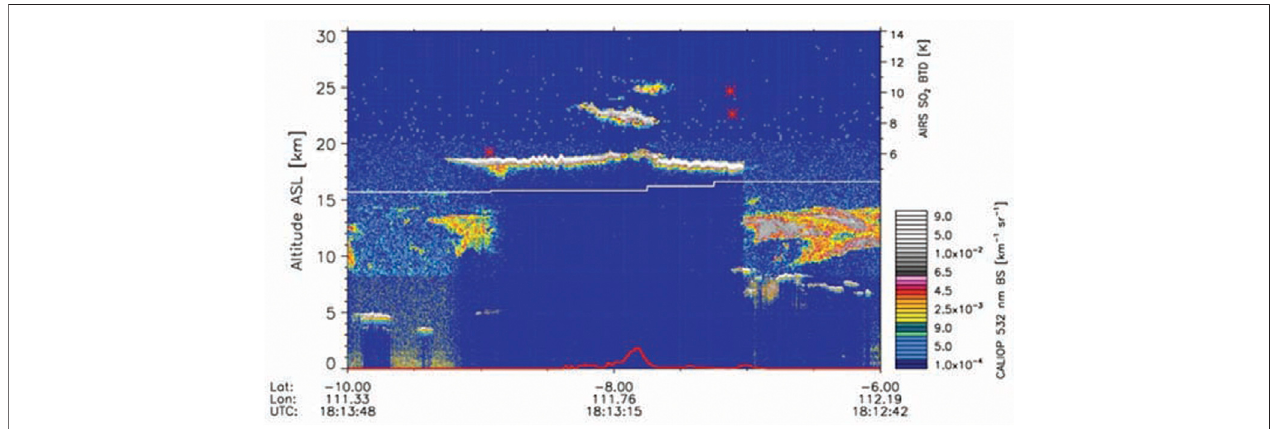
FIGURE12| CALIOPcross-section throughKelut volcanic cloudfrom dataacquired on 14February2014.Top ofplume imagednearcenter; notetopofumbrella spreading region at height above 18 km, and compactness of cloud. Lower bright areas near edges are nonvolcanic water-vapor clouds. (Global Volcanism Program, 2014).